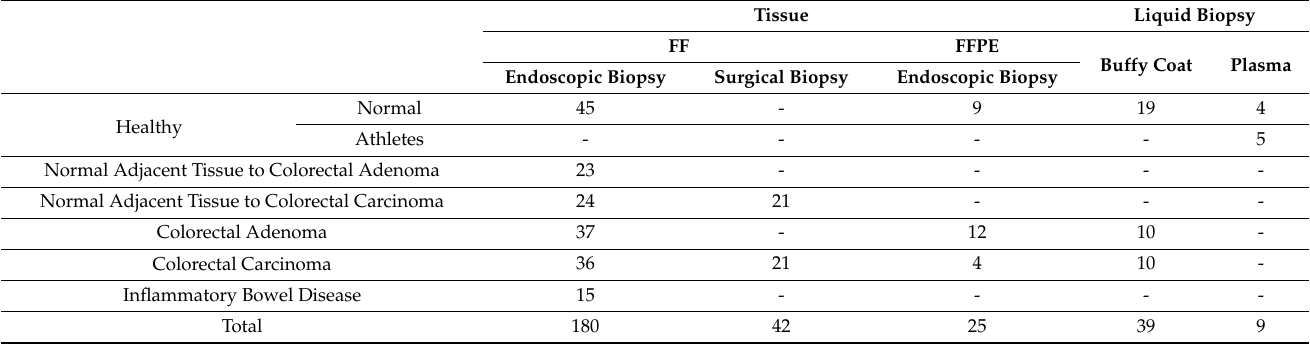
Table 1. Summary of the analyzed sample